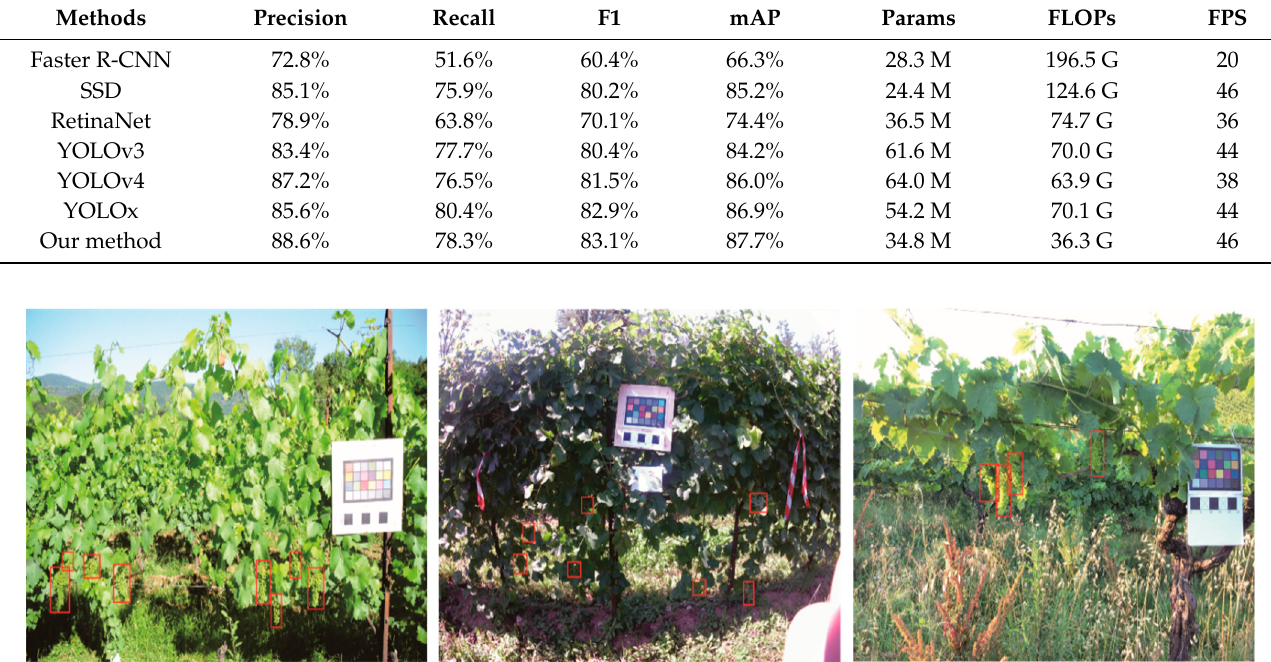
Figure 8. The detection results of our method on the WGISD. ( a ) NMS; ( b ) R-NMS. Table 7. The experimental results on the WGISD using different methods.